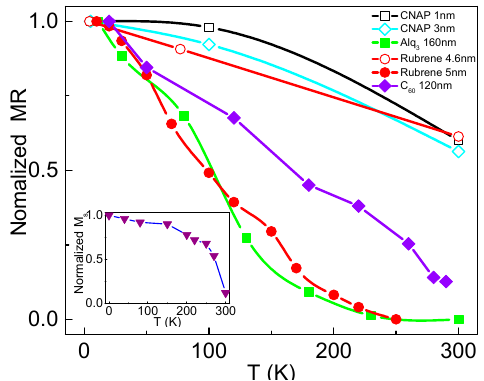
Figure 7. Normalized MR on temperature dependence measured by different groups, all of which decayed with increasing temperature. The hollow dots represent TMR, the solid dots represent GMR. (CNAP, Suzuki et al. [43]; Alq 3 160 nm, Xiong et al. [1]; Rubrene 4.6 nm, Shim et al. [23]; Rubrene 5 nm, Yoo et al. [104]; C 60 120 nm, Liang et al. [60].) The inset shows the magnetization of LSMO versus T, adapted from [1], with permission from © 2004 Springer Nature.